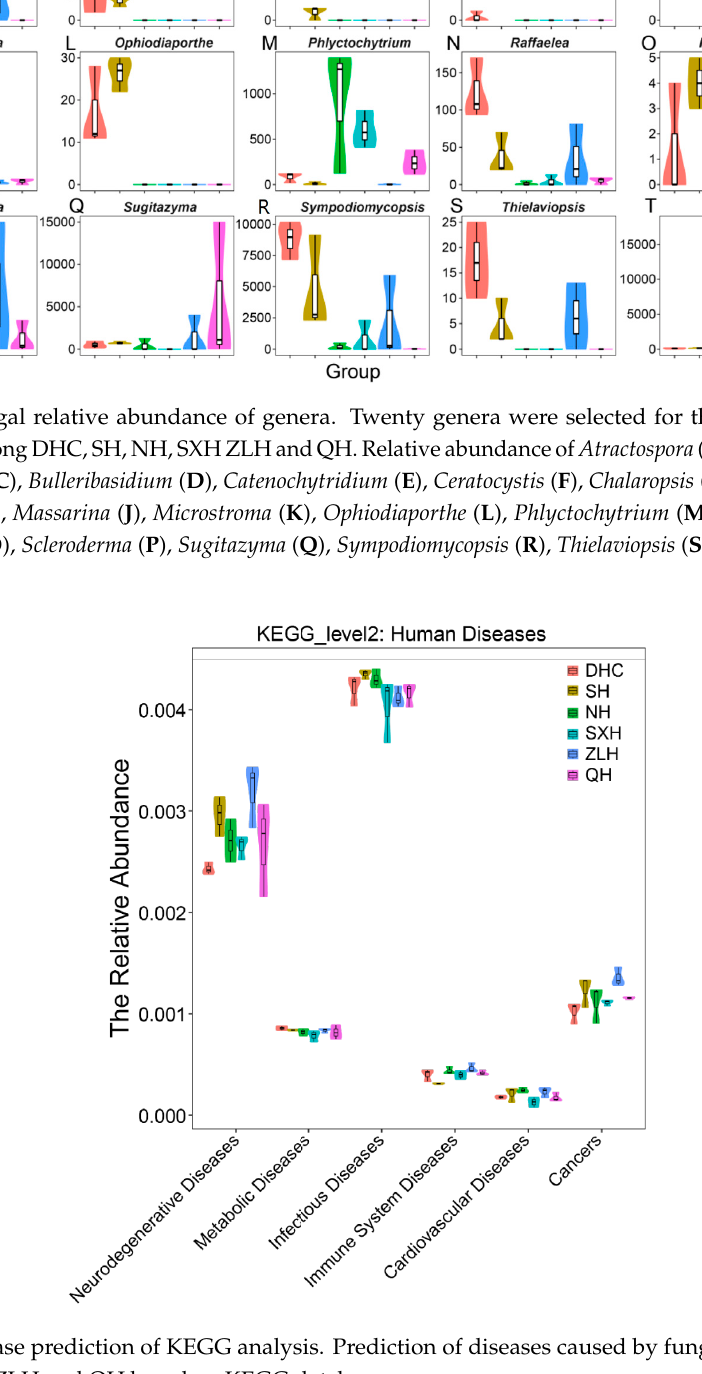
Figure 6. Disease prediction of KEGG analysis. Prediction of diseases caused by fungus from DHC, SH, NH, SXH ZLH and QH based on KEGG database. SH, NH, SXH ZLH and QH based on KEGG